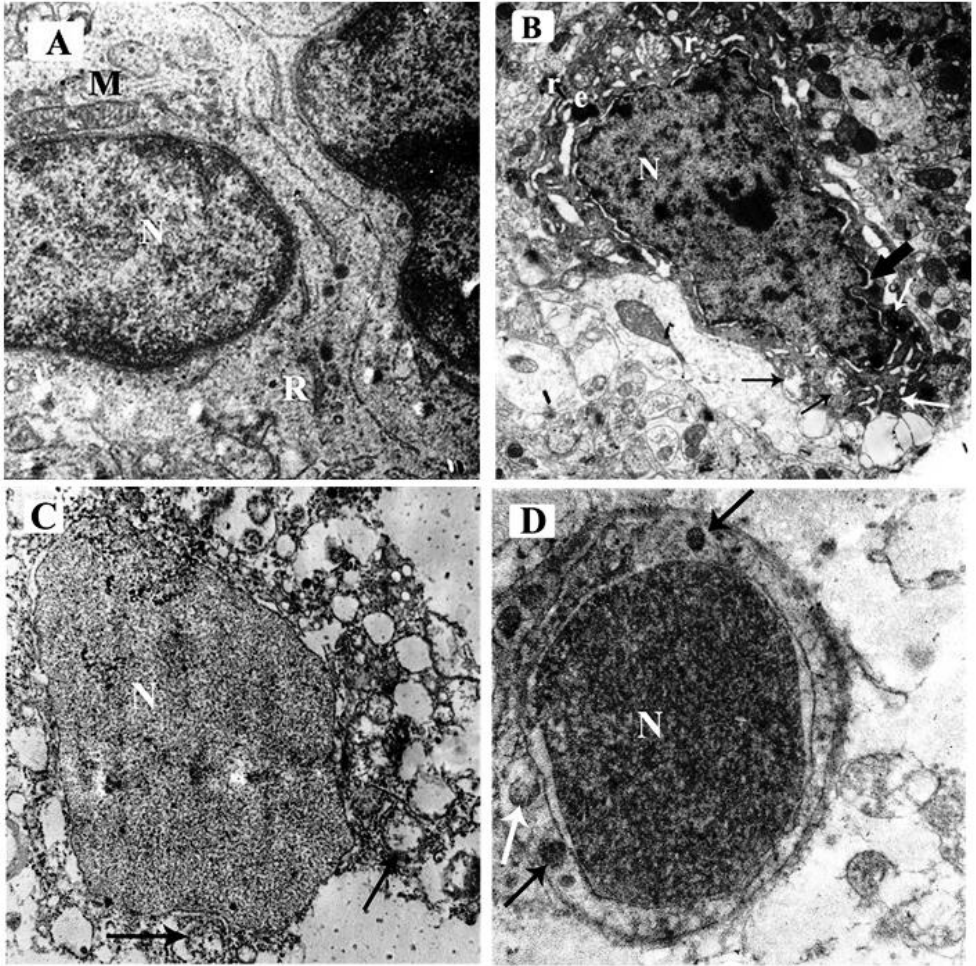
Figure 7. Electron micrographs of the mouse hippocampus in the CA3 region of the di ff erent study groups; ( A ) control group and ceftriaxone group; the pyramidal cell has a euochromatic, central, and rounded nucleus (N) with a smooth bi-laminar nuclear envelope and fine dispersed chromatin. Well-formed rough endoplasmic reticulum (R) and intact mitochondrial (M) are seen. ( B ) ARS group demonstrating distorted dense neuron with an irregular outline. The nucleus (N) has marginated chromatin, chromatin clumps, and is surrounded by perinuclear space (thick black arrow). The cytoplasm shows shrinkage and deposition of electron-dense bodies (e). Some mitochondria are distended with disrupted cristae (black arrow) while others are comparable to the control (white arrow). The rough endoplasmic reticulum is markedly dilated (r). ( C ) ARS group demonstrates markedly a ff ected pyramidal cells with an irregular nucleus (N) and multiple ballooned mitochondria (arrows) with disrupted cristae. ( D ) ARS + ceftriaxone group; the pyramidal cell has a regular-shaped nucleus (N) and is surrounded by a bi-laminar nuclear membrane. The cytoplasm reveals multiple mitochondria comparable to the control (black arrow) while one is ruptured (white arrow). ( × 8000). The ARS group demonstrated a distorted dense neuron with an irregular outline. The nucleus (N) had marginated chromatin, chromatin clumps, and was surrounded by perinuclear space (thick black arrow). The cytoplasm was shrunken and showed deposition of electron-dense bodies (e). Some mitochondria were distended with disrupted cristae (black arrow) while others were comparable to the control (white arrow). The rough endoplasmic reticulum was markedly dilated (r) (Figure